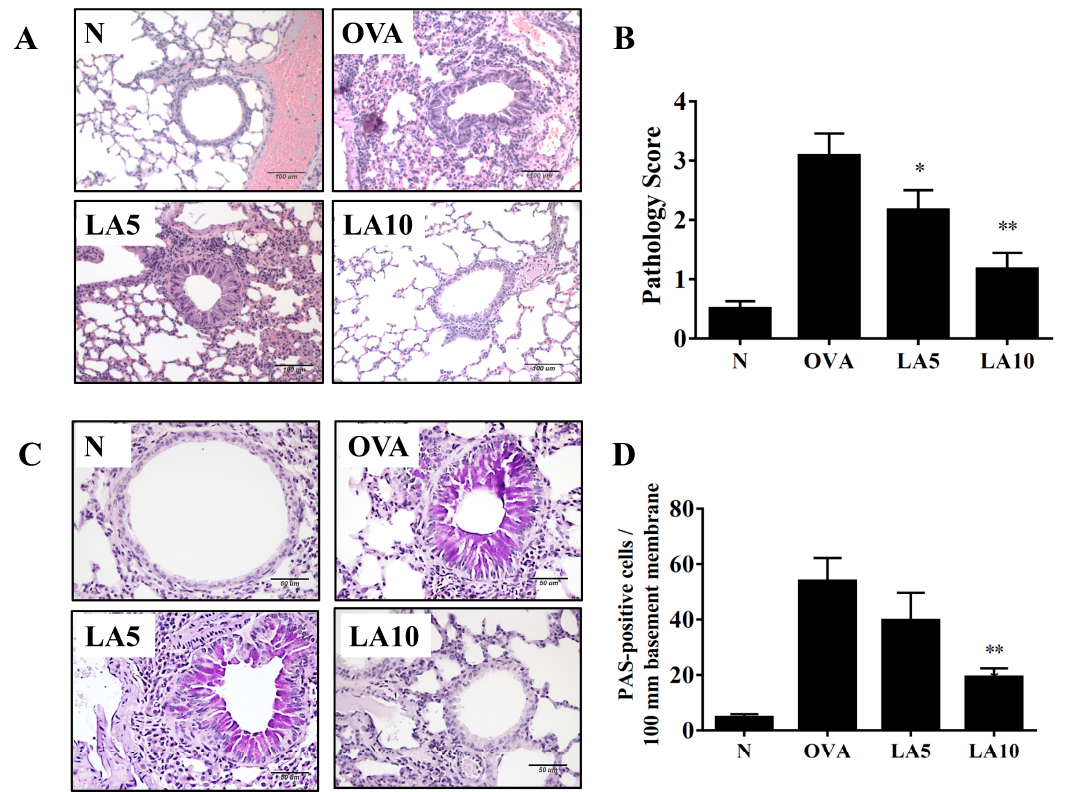
Figure 2. E ff ects of licochalcone A (LA) on asthmatic lung tissue. Histological sections of lung tissues from normal (N) and OVA-stimulated (OVA) mice with or without LA (LA5 and LA10) treatment. ( A ) LA reduced eosinophil infiltration (HE stain; 200 × magnification) and ( B ) scoring of inflammation in pathological evaluation of inflammatory cell infiltration in lung sections. ( C ) Periodic acid–Schi ff (PAS)-stained lung sections demonstrated goblet cell hyperplasia. Goblet cells are indicated with arrows (200 × magnification). ( D ) Results were expressed as the number of PAS-positive cells per 100 µ m of basement membrane. Three independent experiments were analyzed, and data were presented as mean ± SEM. * P < 0.05 compared to the OVA control group. ** P < 0.01 compared to the OVA control group.